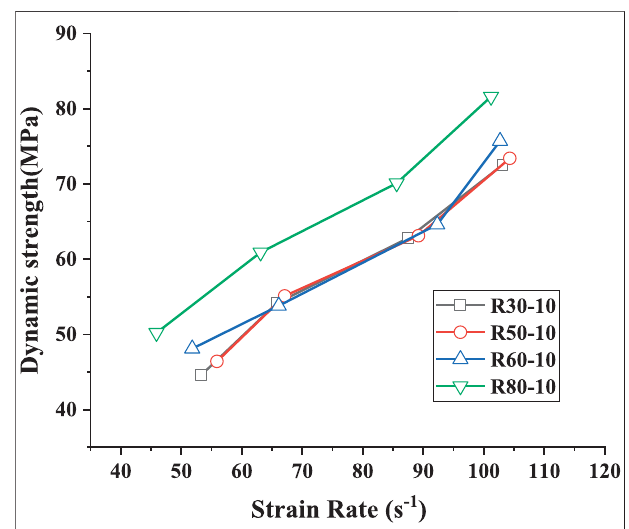
FIGURE 12 | Relationship between dynamic strength and strain rate of mortar with different contents of crumb rubber.